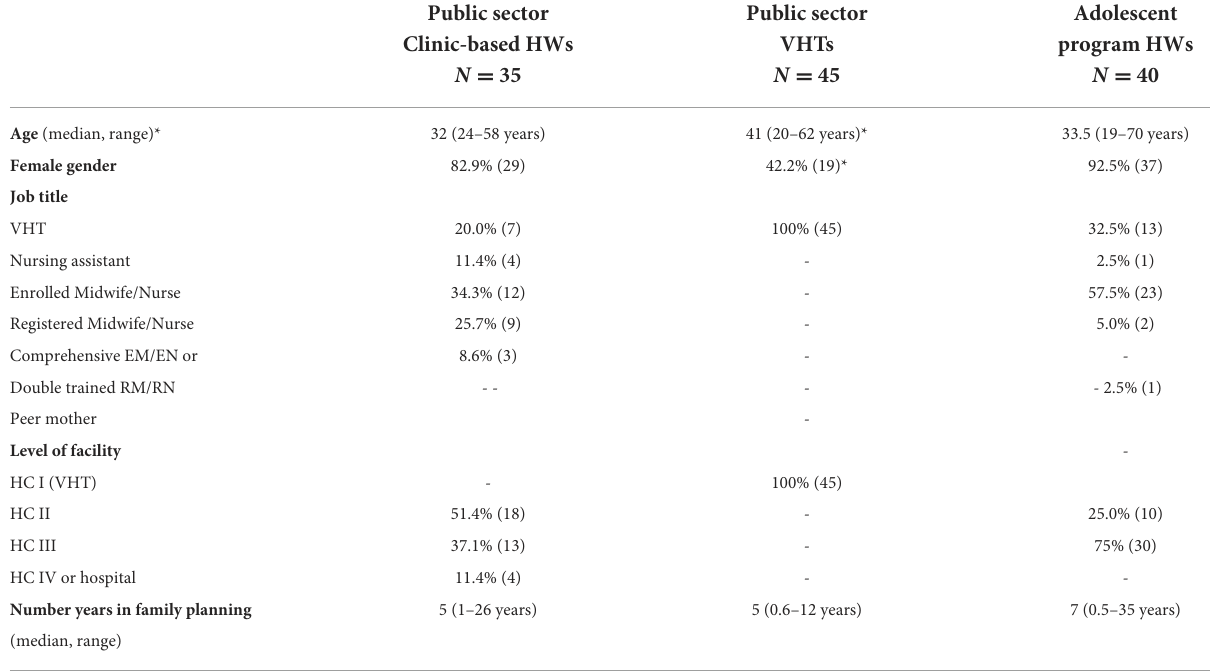
TABLE 1 Background characteristics of health workers (survey